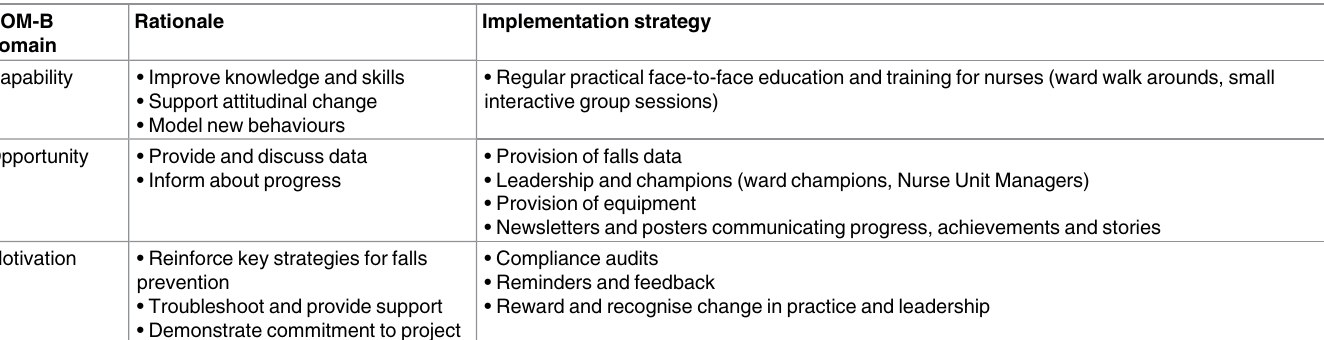
Table 3. Strategies to optimise successful implementation of the 6-PACK